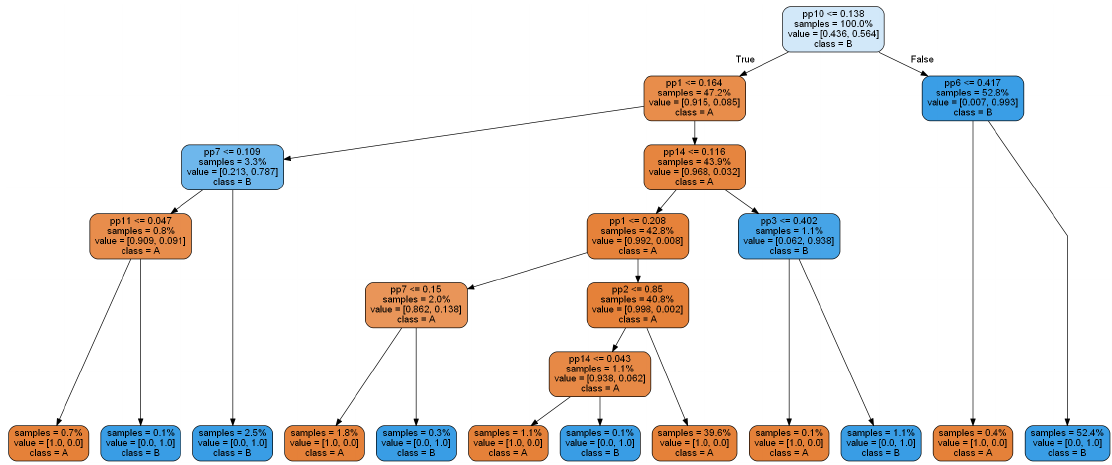
Figure 6. An example of a decision tree, built by the CART algorithm with the Gini criterion based on the training